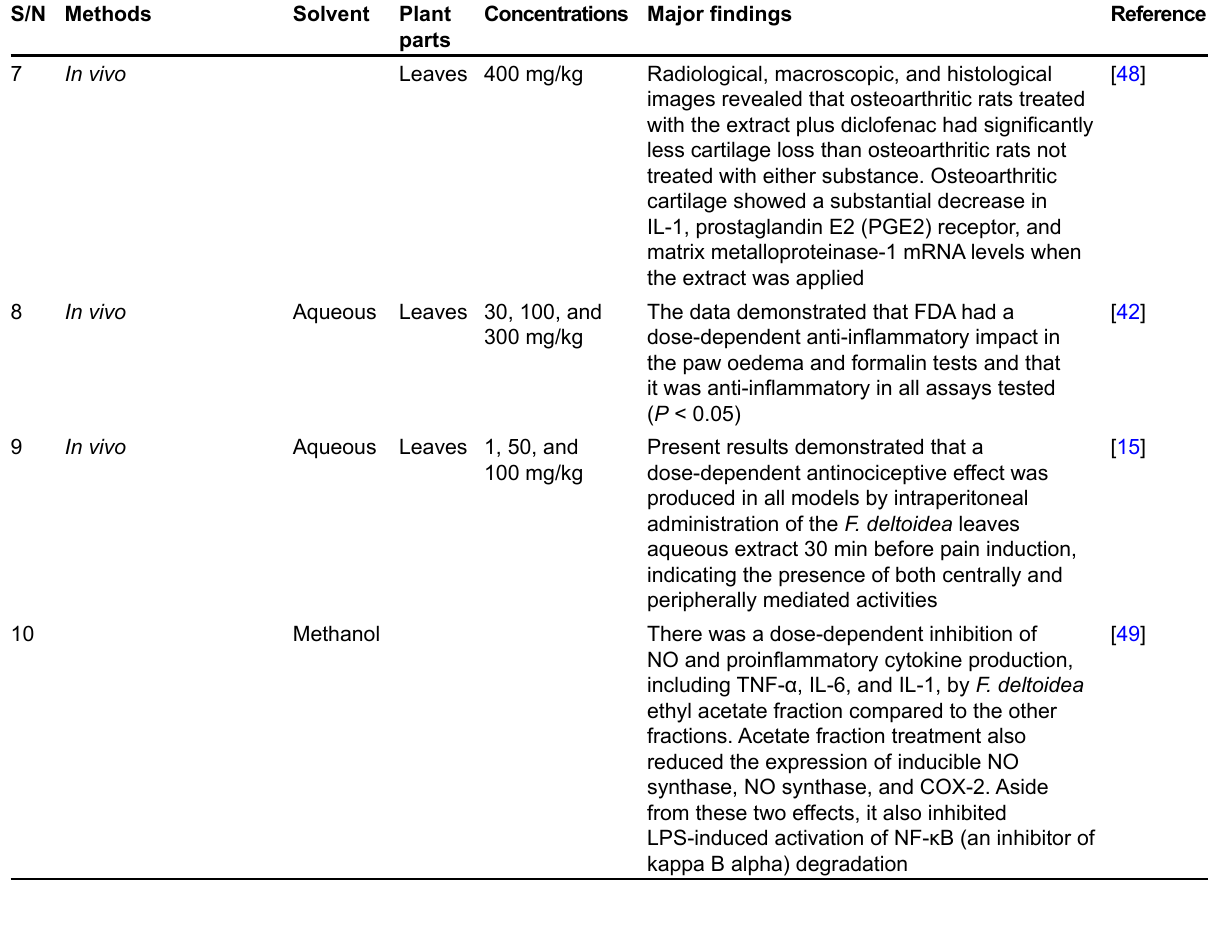
Table 2. Anti-inflammatory activity of FD ( continued )